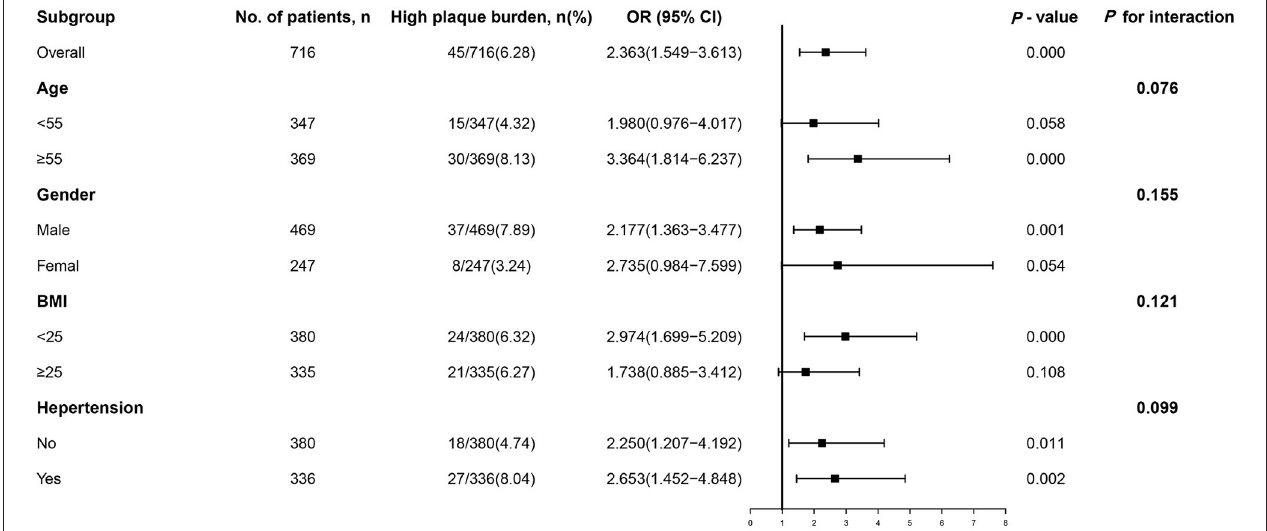
FIGURE 3 | Subgroup analysis of the association between the TyG index and high plaque burden. Logistic regression after adjustment for triglycerides and fasting blood glucose was performed in subgroups according to age, sex, BMI, hypertension, smoking, and alcohol consumption. OR, odds ratio; CI, confidence interval; BMI, body mass index; TyG, triglyceride-glucose.